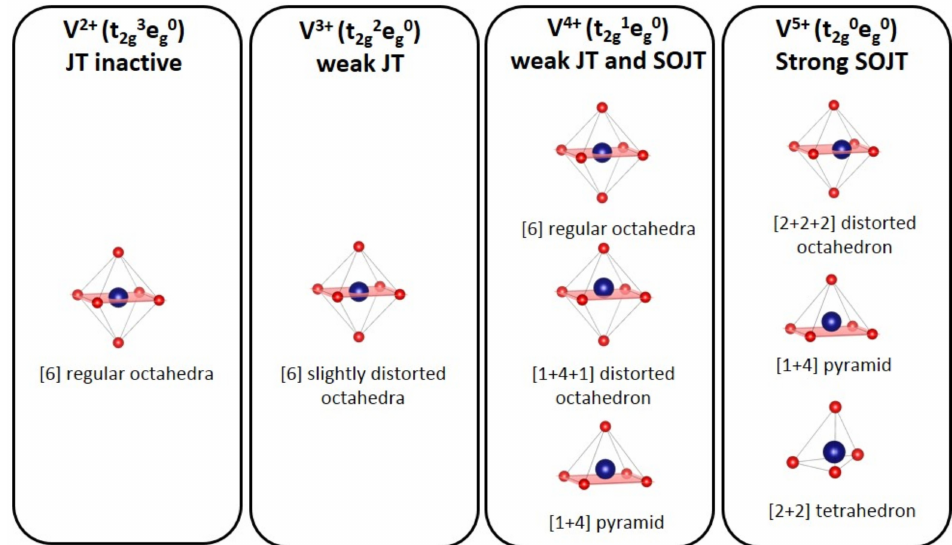
Figure 2. Stable environments of vanadium according to its oxidation state [15]. The number in square brackets correspond to the number of “equivalent